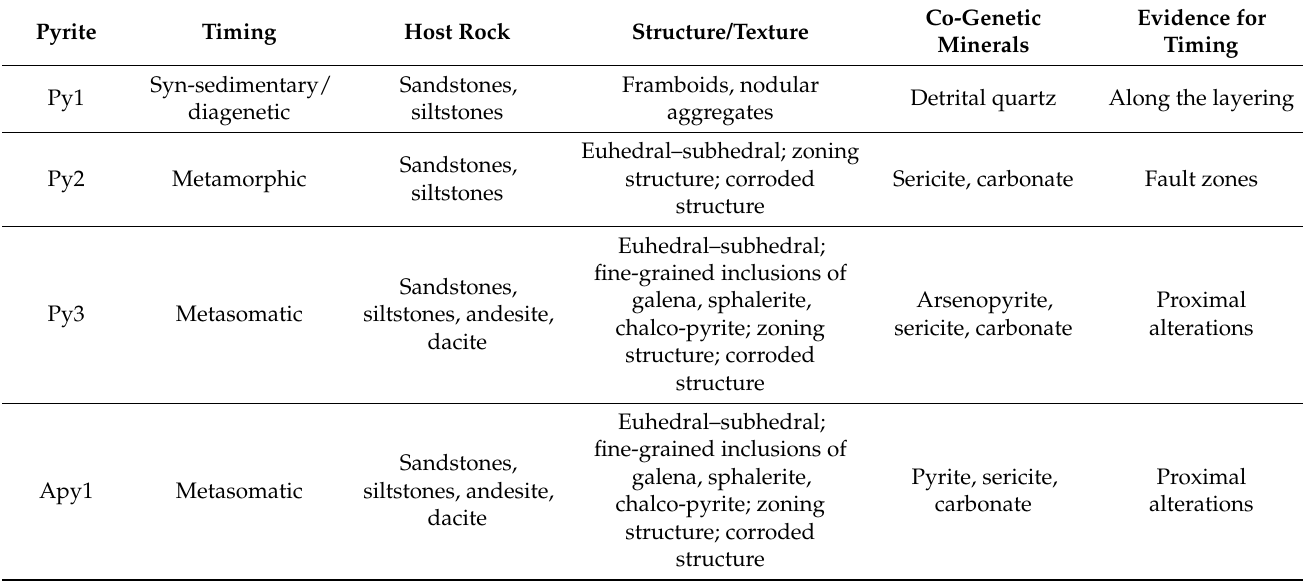
Table 3. Summary of common textures and pyrite–arsenopyrite classification OGDs Central